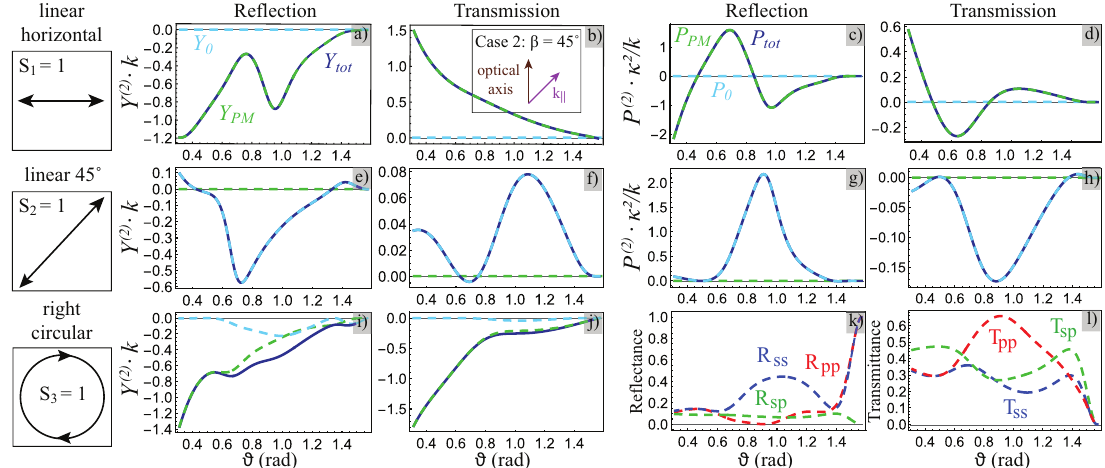
Figure 4. Case 2: the optical axis of the QWP is rotated at β = 45 ◦ with respect to beam incidence plane, see insert in ( b ). ( a – j ) linear ( a , b , e , f , i , j ) and angular ( c , d , g , h ) IF shifts in reflection ( a , c , e , g , i ) and transmission ( b , d , f , h , j ) configurations for the horizontal ( a – d ), linear at 45 ◦ ( e – h ) and right-handed circular ( i , j ) polarizations characterized by the Stokes parameters S 1 = 1, S 2 = 1 and S 3 = 1, respectively. Dashed cyan and solid blue lines correspond to the standard (Equation (7) for linear and Equation (11) for angular) and total (Equation (10) for linear and Equation (14) for angular) IF shifts, respectively. The total one takes into account the PM contribution (Equation (9) for linear and Equation (13) for angular) shown by the dashed green line. ( k , l ) co-polarized (blue and red lines) and cross-polarized (dashed green line) ( k ) reflectances ( R ij = | f r a central plane